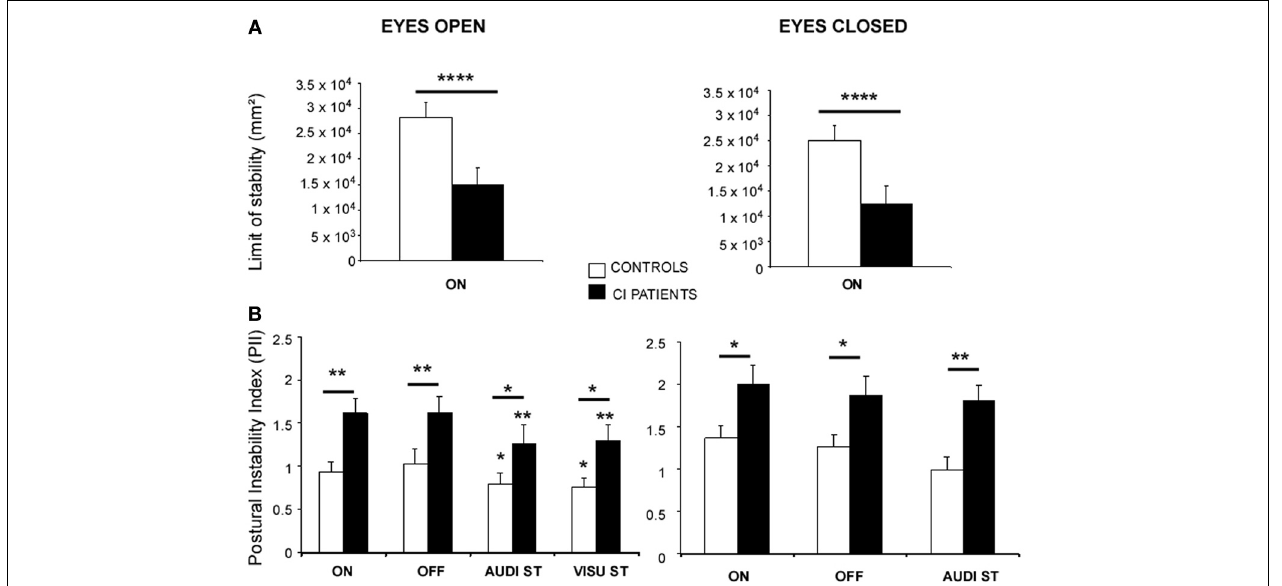
FIGURE 1 | (A,B) Posture control of the CI patients in static conditions. (A) Limits of stability of the CI patients (filled histograms) compared to the controls (open histograms) in the eyes open (EO) and eyes closed (EC) conditions. The stability limits are expressed as the energy of the spectral power density recorded in the 0.05–0.5Hz frequency range while the subjects were standing on the platform and asked to move voluntary as far as possible in the forward/backward and left/right directions, without moving the feet. ∗∗∗∗ Significant differences ( p < 0 . 0001) between the CI patients and the controls. ON indicates that hearing is present. (B)